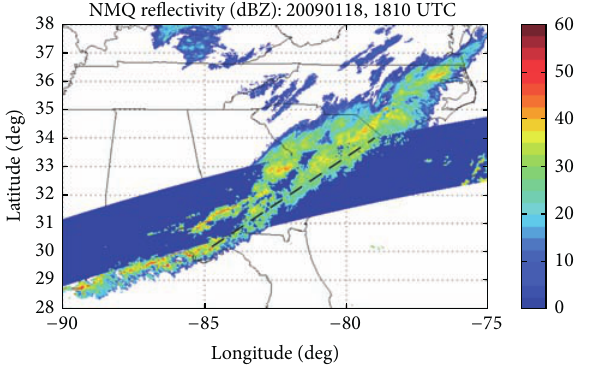
Figure 7: The TRMM track shown over the NMQ composite reflectivity from 18 January, 2009 at 1810 UTC.